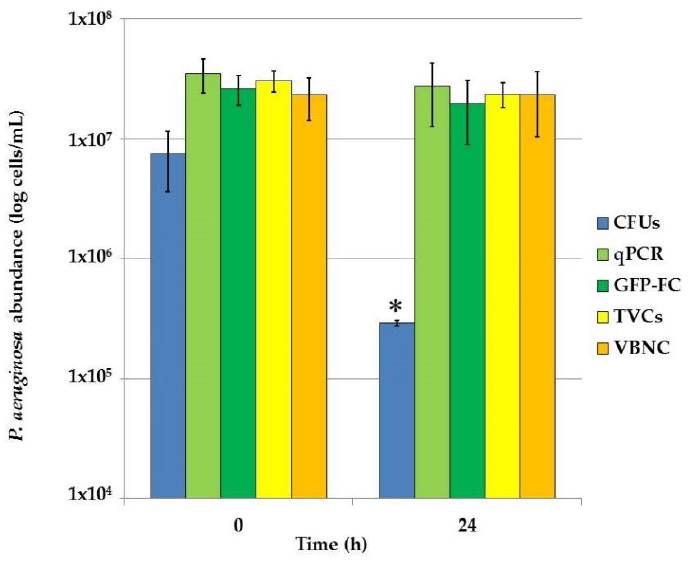
Figure 4. Piperacillin persistence assays of P. aeruginosa biofilms. P. aeruginosa PAEG1 biofilms were developed in LB broth for 24 h at 37 °C; then, the medium was removed and replaced with LB broth containing piperacillin 4 mg/mL (1000 × MIC) and biofilms were maintained in these conditions for 24 h at 37 °C. Immediately before (0 h) and after (24 h) antibiotic exposure, the amounts of culturable persisters (CFUs) and Total Viable Cells (TVCs) were determined by plate count and qPCR/ GFP-based flow cytometry (GFP-FC) assays, respectively. The amount of viable but non- culturable (VBNC) cells were determined as the difference between TVCs and CFUs. The results are expressed as average of three biological replicates ± standard deviation. *, p < 0.05.